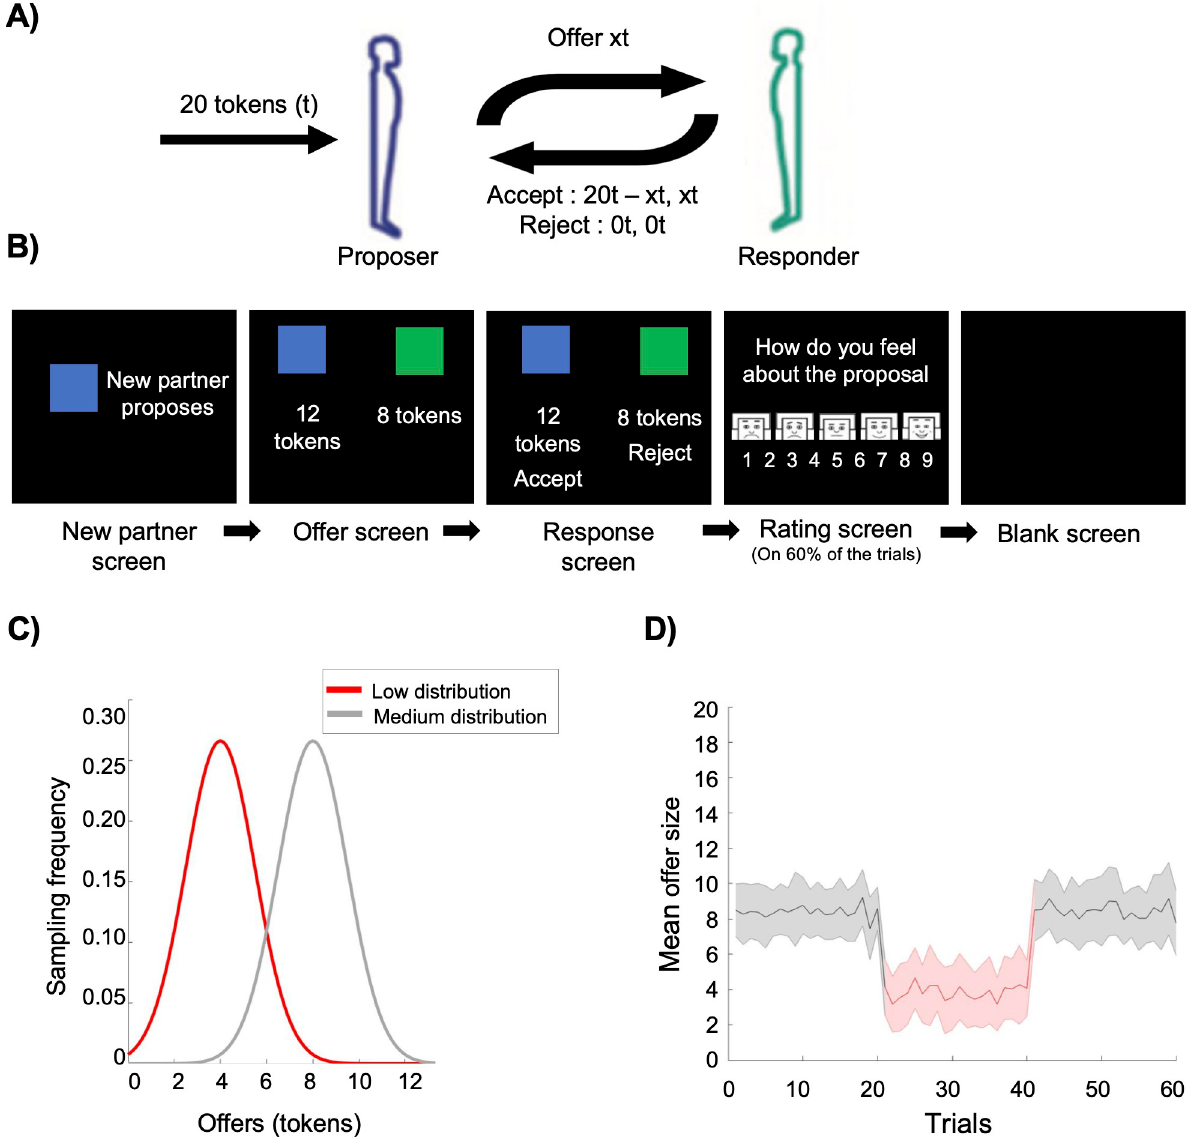
Fig 1. Visual representation of the Ultimatum game. (A) Representation of the exchange process between the Proposer and the Responder. (B) Visual display of the task. Each trial starts with the presentation of a new partner followed by the offer presentation after which children were asked to choose between accepting and rejecting the offer. For 60% of the trials, children had to rate their feeling regarding the offer received using the visual scale shown in the Rating screen. (C) Offers were sampled from two Gaussian distributions. Baseline and Post-conditioning offers were sampled from the medium distribution (mean 8 tokens, SD 1.5 tokens) and conditioning offers were sampled from de low distribution (mean 4 tokens, SD 1.5 tokens). (D) Average offers received throughout the task.